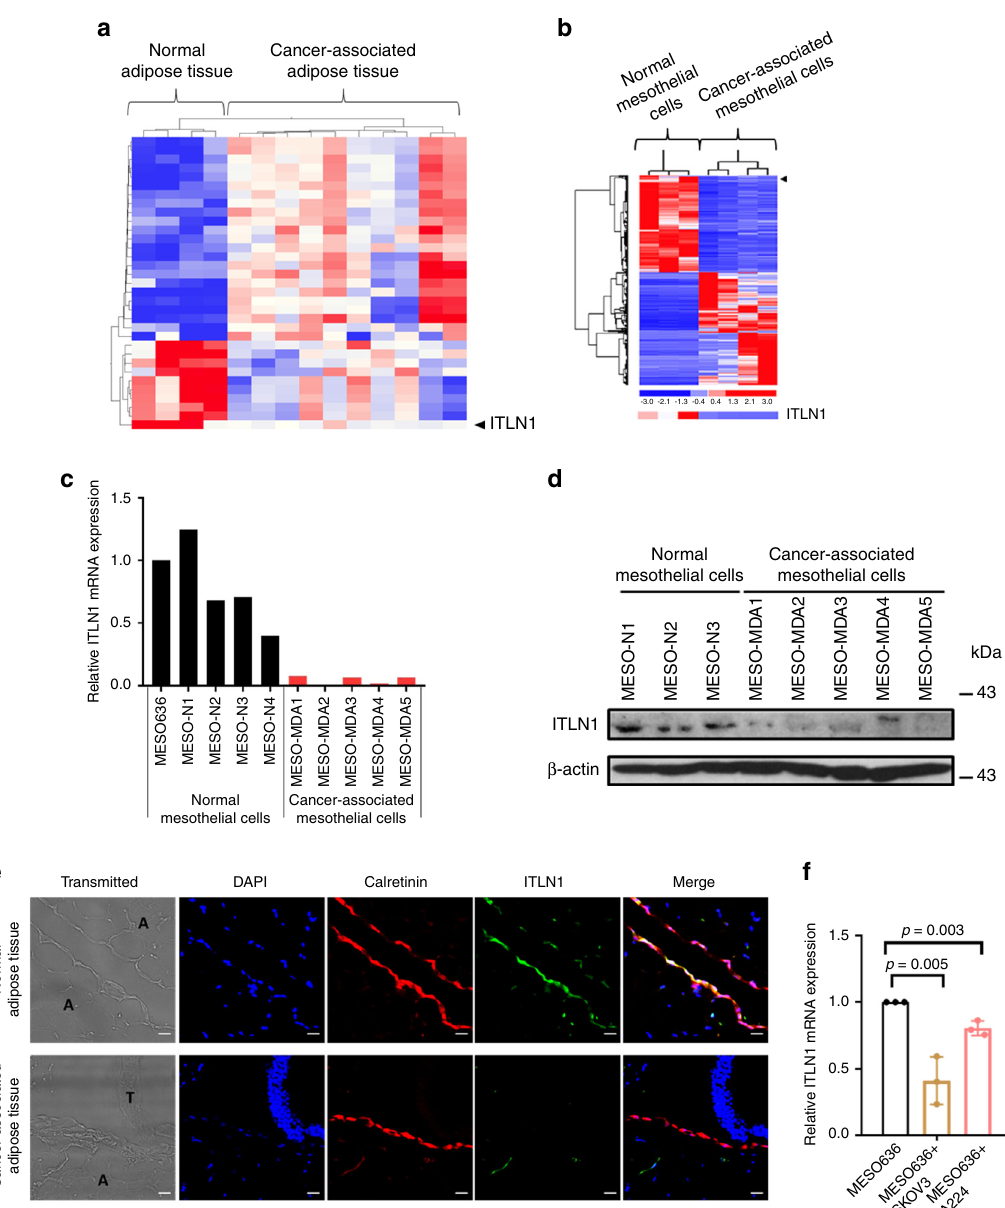
Fig. 1 ITLN1 expression is downregulated in ovarian cancer-associated mesothelial cells. Heat map obtained ( a ) using transcriptome pro fi ling analysis shows ITLN1 expression is signi fi cantly decreased in microdissected ovarian cancer-associated omental adipose tissue samples from HGSC patients ( n = 10) compared with normal omental adipose tissue samples from patients with benign gynecologic diseases ( n = 4); b using RNA-sequencing technique shows ITLN1 expression is signi fi cantly decreased in ovarian cancer-associated mesothelial cells derived from ascites of HGSC patients ( n = 4) compared with commercially purchased, normal mesothelial cells ( n = 3). c QRT-PCR and d western blot analyses show a lower ITLN1 mRNA and protein expressions in ovarian cancer-associated mesothelial cells ( n = 5) compared with normal mesothelial cells ( n = 5 and n = 3, respectively). β -actin served as a loading control. e Representative microscopic images from immunolocalization show a lower ITLN1 expression level in the mesothelial cell layer (calretinin- positive) covering the ovarian cancer-associated omental adipose tissues compared with normal adipose tissues from healthy women. A adipocytes, T tumors; Bar = 40 μ m; n = 3. f QRT-PCR analysis shows a lower ITLN1 mRNA level in MESO636 co-cultured with SKOV3 and A224 compared with MESO636 cultured alone. Results from three independent experiments were averaged and are shown as mean ± SD (two-tailed t